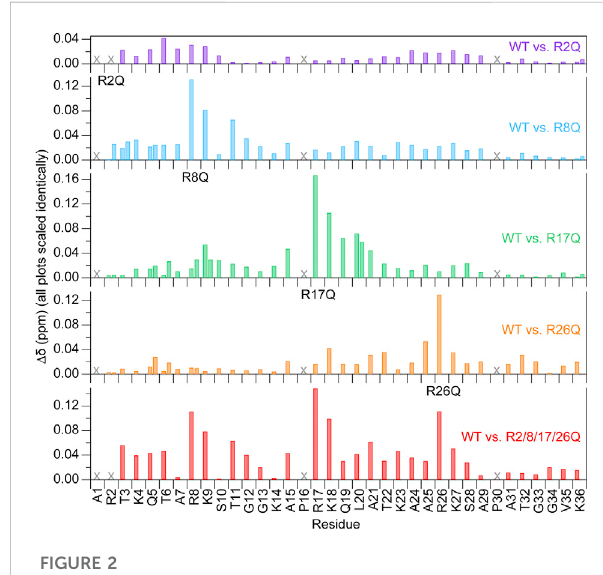
FIGURE 2 Chemical shift perturbations are localized near the mutated arginineat0 mMKCl.Chemicalshiftperturbations( Δ δ )areplottedasa function of H3 tail residue for 1 H- 15 N HSQC spectra of each mutant as compared to WT-H3-NCP at 0 mM KCl. Two values are plotted for doublet peaks (see Section 2). “ X ” symbols mark residues that are not visible. Data were collected at 800 MHz and 304